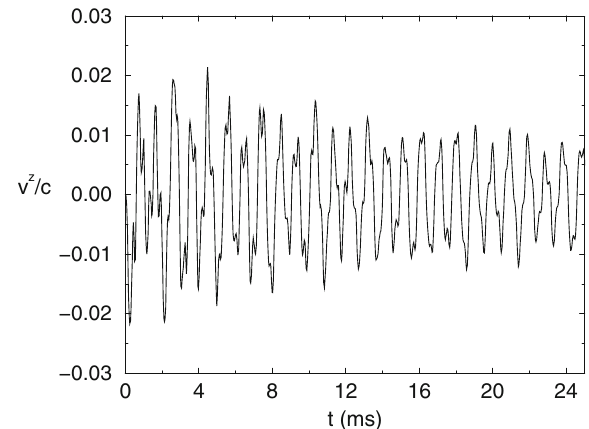
Fig. 20 Evolution of the axial velocity in the equatorial plane for a relativistic r -mode in a rapidly rotating N = 1 . 0 polytrope (in the Cowling approximation). Since the initial data used to excite the mode are not exact, the evolution is a superposition of (mainly) the l = m = 2 r -mode and several inertial modes. The amplitude of the oscillation decreases due to numerical (finite-differencing) viscosity of the code. A beating between the l = m = 2 r -mode and another inertial mode can also be seen. (Image reproduced with permission from Stergioulas and Font 2001, copyright by